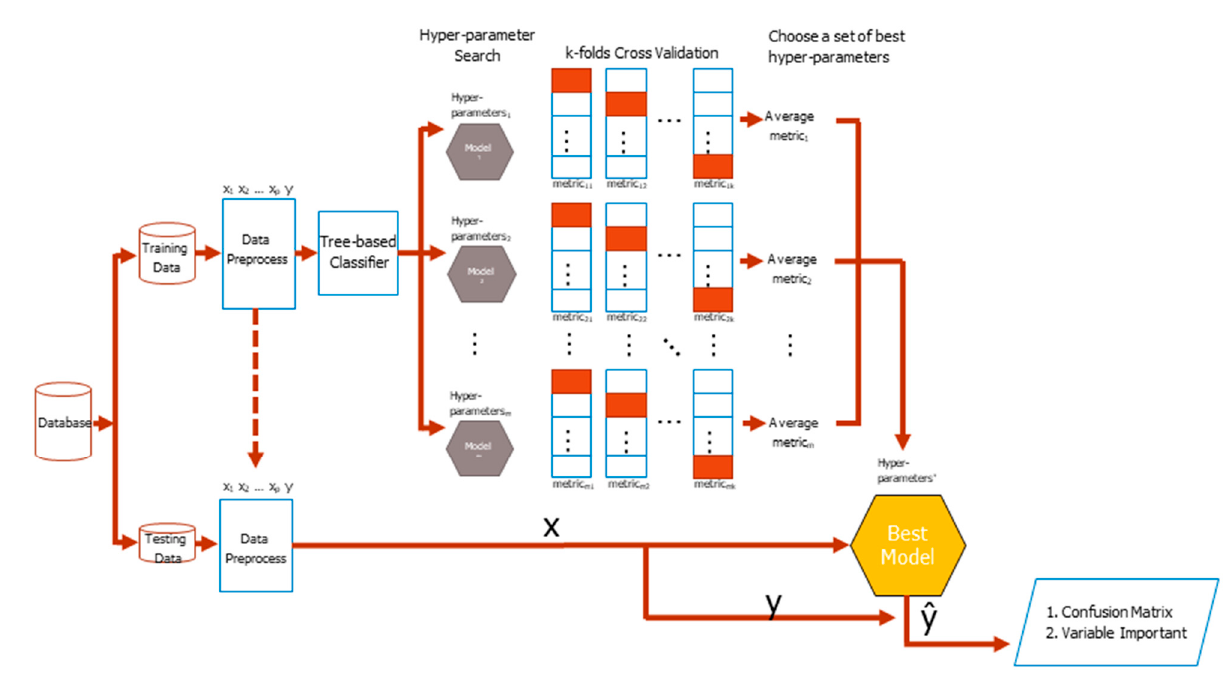
Figure 2. The basic flowchart of classification. ‘*’ means the select optimal set of hyper-parameters. p, m, k mean number of features, number of search times, and number of folds.